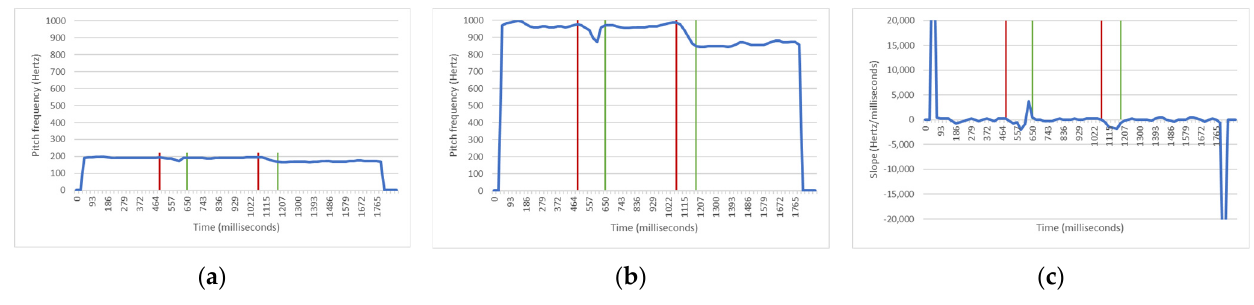
Figure 3. Analyzing the pitch contour. ( a ) The original pitch contour of three notes, the first two notes are the same, and the third one is lower than the previous notes, ( b ) the stretched estimated values for the fundamental frequencies in ( a ), and ( c ) the slope of the pitch contour computed using differentiation. The red lines show the possible points for offsets, and the green lines are possible onsets.